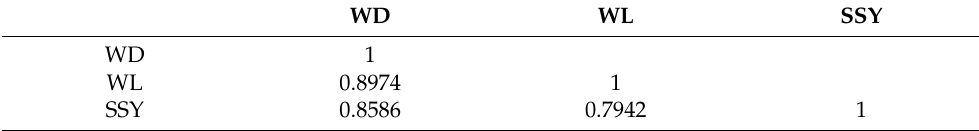
Table 2. Pearson Correlation coefficient of data at Polavaram, Godavari River Basin.